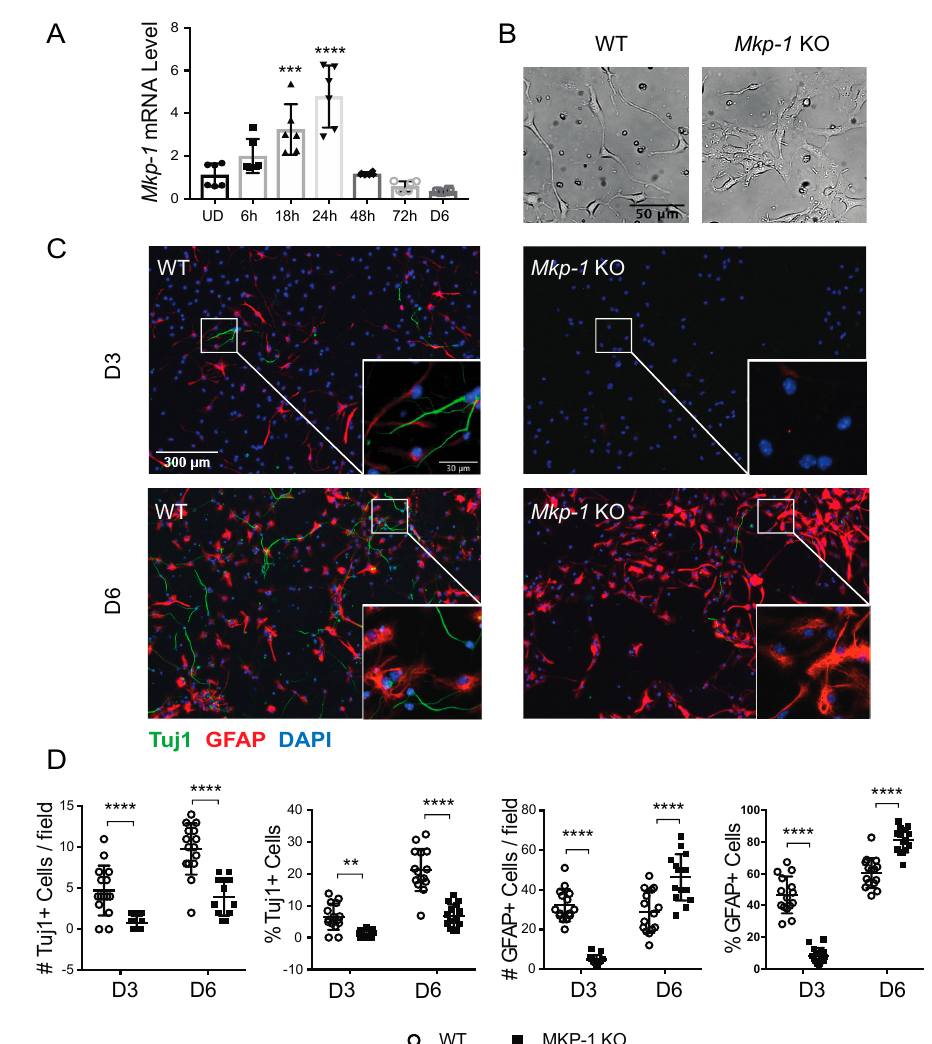
Figure 2. Loss of MKP-1 inhibits neurogenesis in differentiated NSC cultures. ( A ) Time course analysis of Mkp-1 mRNA fold-change in expression in differentiated wild-type neural stem cells compared with undifferentiated (UD) cultures ( n = 6, one-way ANOVA, *** p < 0.001, **** p < 0.0001). ( B ) Live-cell images of WT and Mkp-1 KO neural stem cultures 24 h post-differentiation. ( C ) Immuno- cytochemical staining of differentiated WT and Mkp-1 KO NSCs for Tuj1 (green) and GFAP (red) on day 3 (D3) and day 6 (D6) post-differentiation. ( D ) Absolute counts (#) per field and fraction (%) of Tuj1+ and GFAP+ cells relative to total cell # per field at D3 and D6 ( n = 15, two-way ANOVA, ** p < 0.01, **** p < 0.0001).